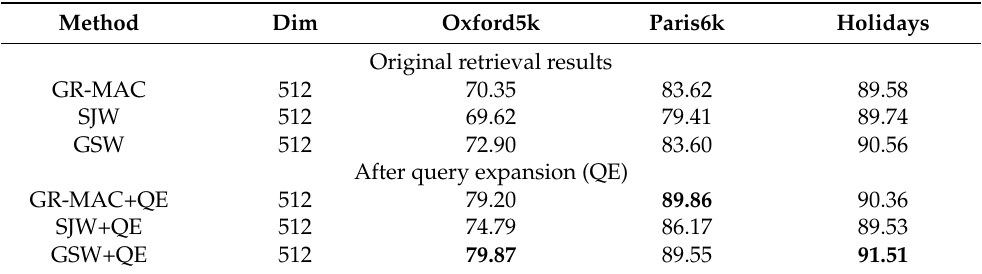
Table 5. Performance (mAP) comparison using query expansion or not. QE: using query expansion (+QE). We use bold colors to highlight the best result. GSW, global saliency weighted. Method